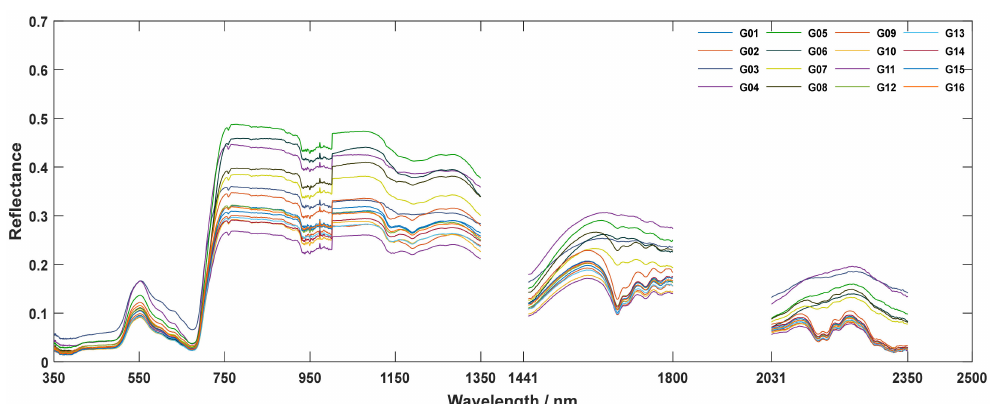
Figure 1. Workflow of the method.